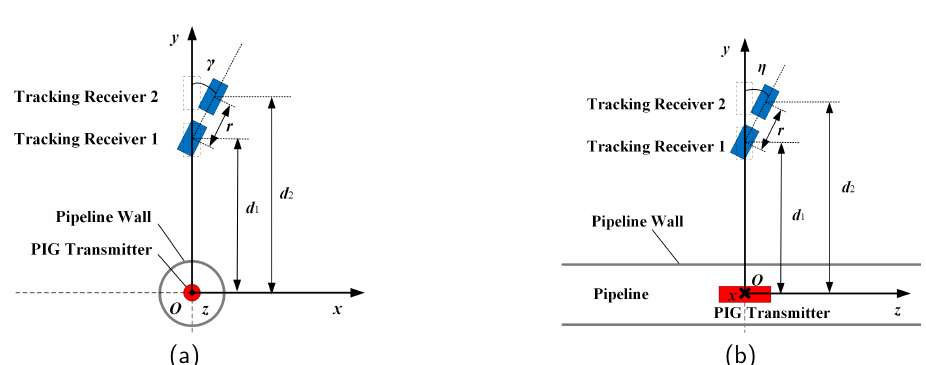
Figure 13. The dual receivers are in unexpected cases: ( a ) the receivers are tilted in the x - y plane, ( b ) the receivers are tilted in the y - z